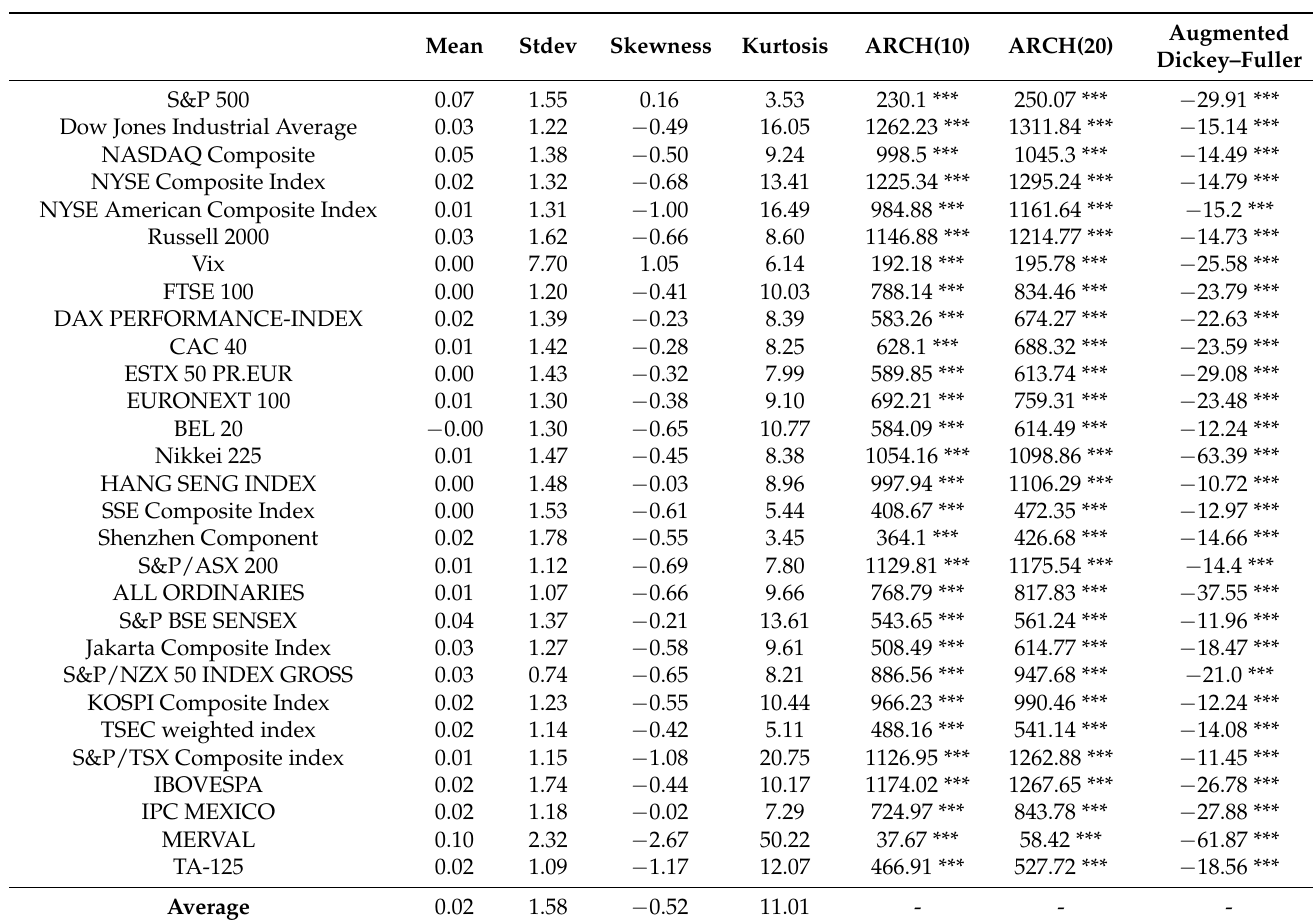
Table 1. Descriptive statistics for the entire sample of international financial